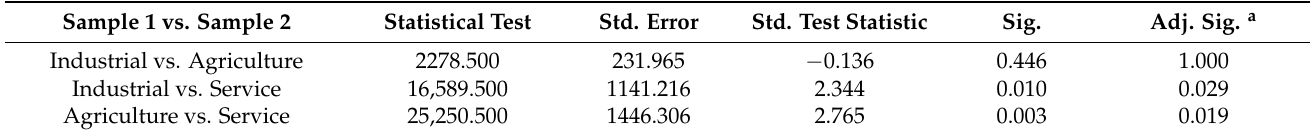
Table 12. Pairwise comparisons of sectoral economic participation.